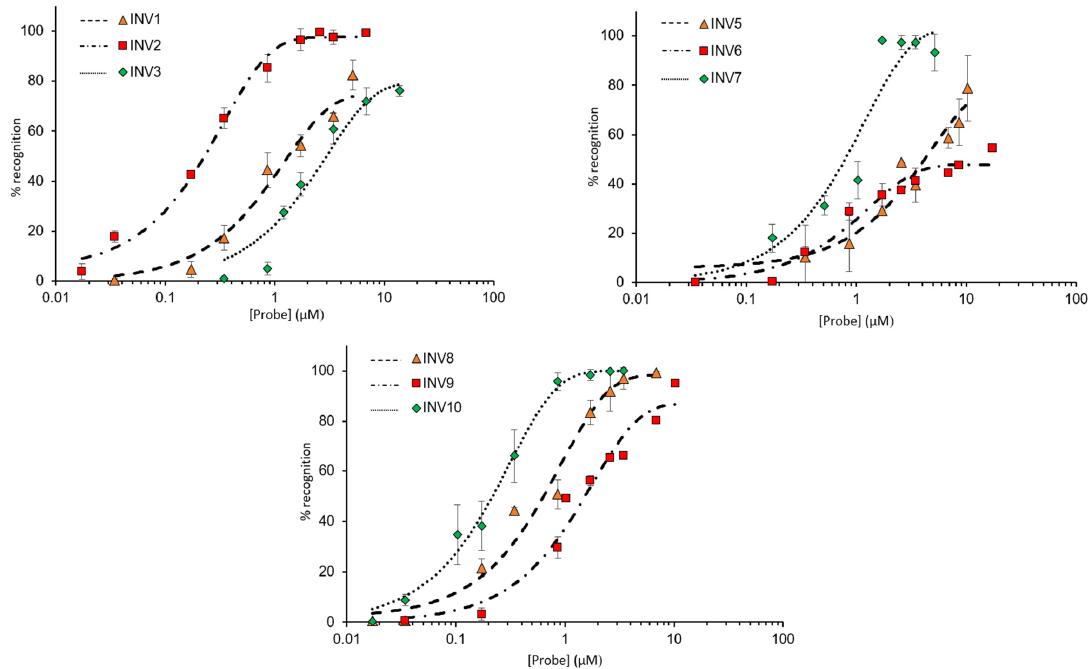
Figure 4. Dose–response curves for recognition of DNA hairpins using INV1-INV3 (upper left panel), INV5-INV7 (upper right panel), and INV8-INV10 (lower panel). Probes were incubated with their respective DNA hairpin targets for 15 h at 37 °C. Experimental conditions are as described in Figure 3, except for variable probe concentrations. Bars denote standard deviations. For the corresponding electrophoretograms, see Figures S11–S13. Table 3. Rec 100× and C 50 values for recognition of model DNA hairpin targets when using the corresponding Invader probes a .